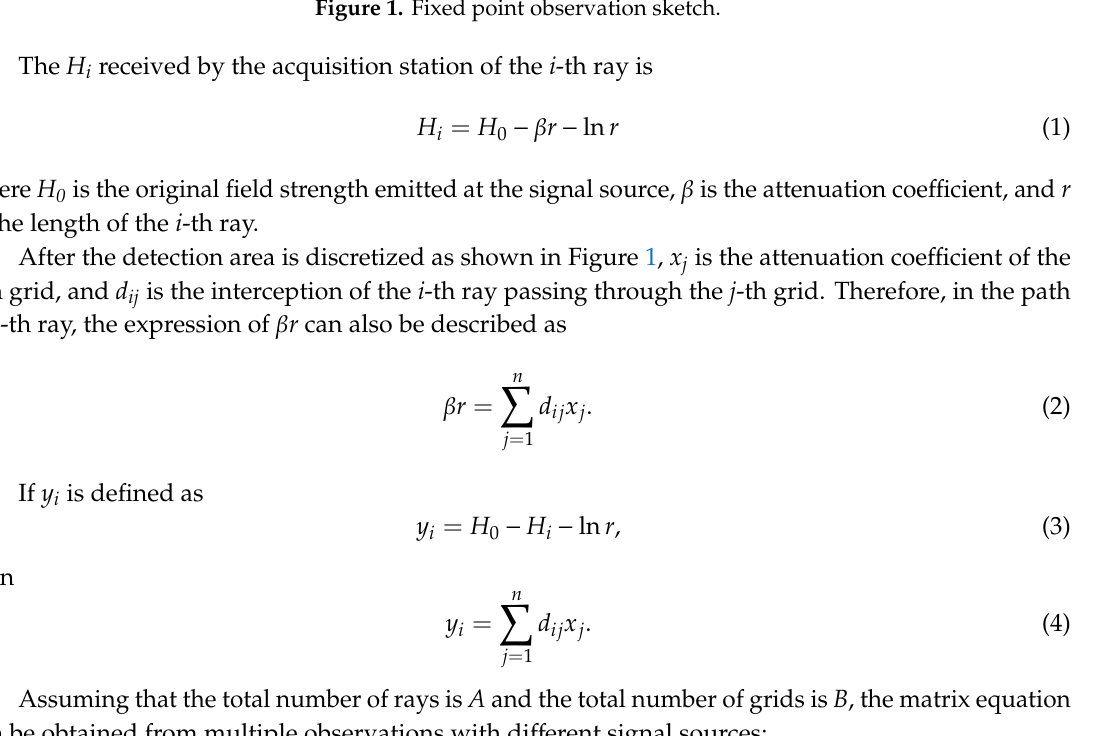
Figure 1. Fixed point observation sketch.